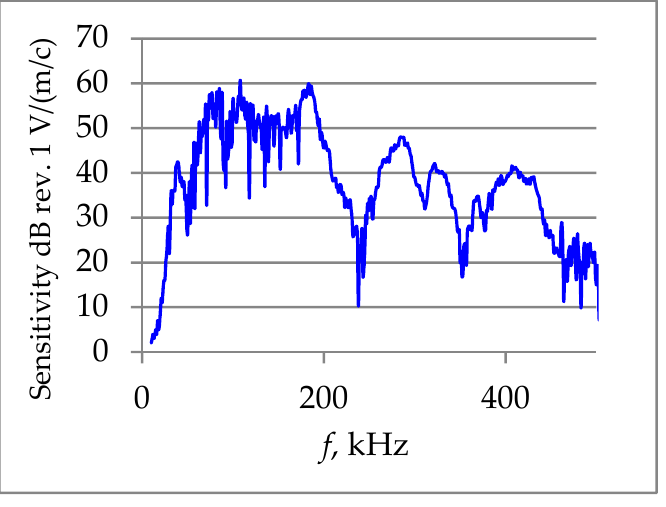
Figure 2. Frequency response of AE sensor GT200.